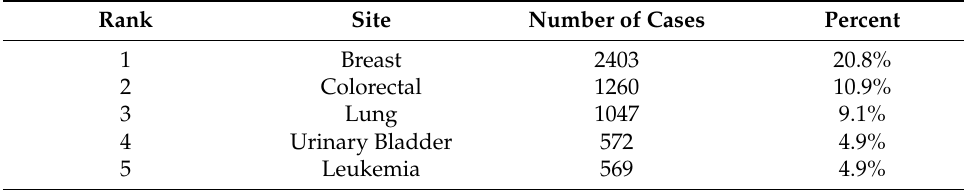
Table 1. The most common cancers in Jordan, both sexes, all ages, in 2020.